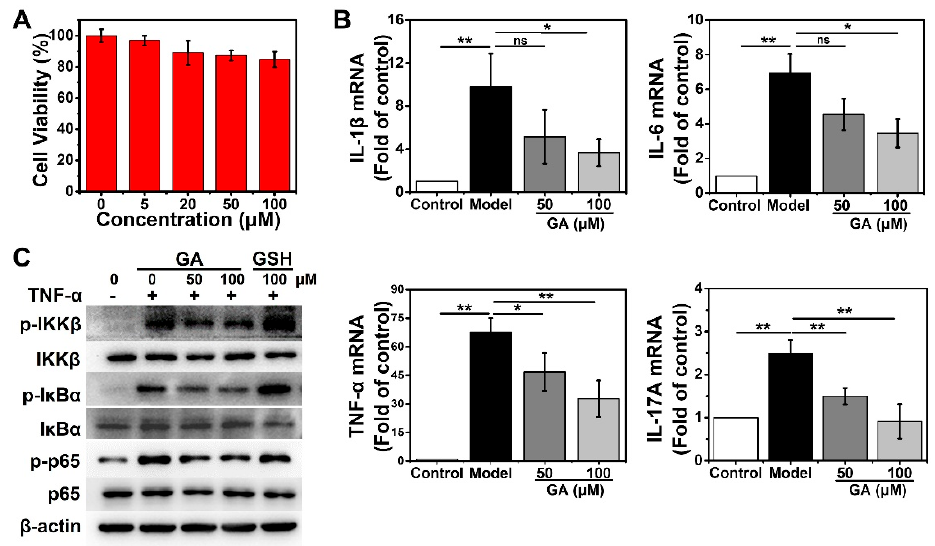
Figure 2. Effect of Au nanocluster on NF- κ B pathway activation and proinflammatory cytokines expression in human keratinocytes. ( A ) CCK8 assay for cell viability of HaCaT cells after incubation with the indicated concentrations of GA for 24 h. The data are presented as mean ± SD of triplicate experiments. ( B ) Effects of GA on TNF- α (20 ng/mL)-induced transcription of IL-1 β , IL-6, TNF- α and IL-17A in HaCaT cells after 24 h of incubation detected by RT-qPCR. The data are provided as mean ± SD of triplicate experiments; * p < 0.05, ** p < 0.01 and n.s., not significant. ( C ) Western blotting was used to determine the expression and phosphorylation of IKK β , I κ B α and p65 following a 24 h incubation with TNF- α and GA or free glutathione. The loading control was β -actin. Presented is one result from three distinct trials.